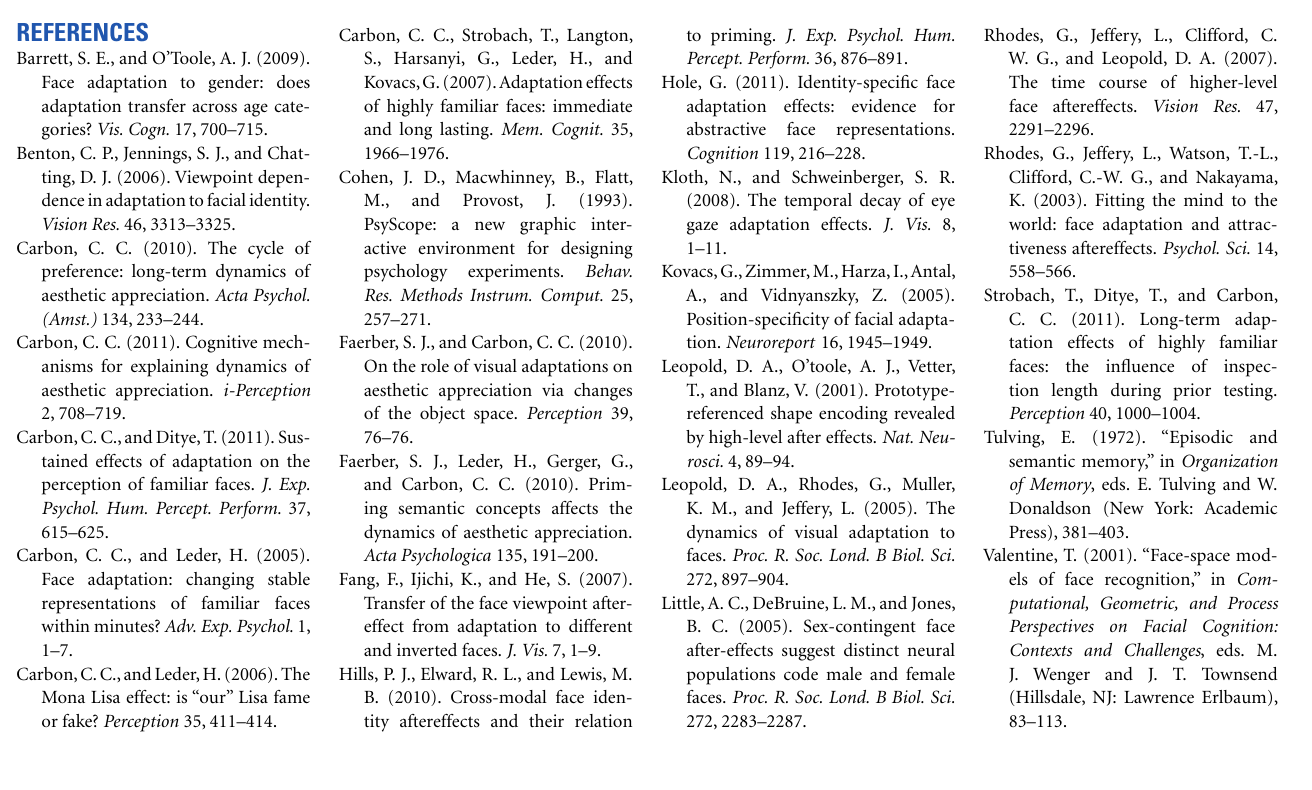
FIGURE 4 |Adaptation effects for the stimulus compatibility conditions picture (same depiction of the same persons in the adaptation and test phase), identity (different depictions of the same